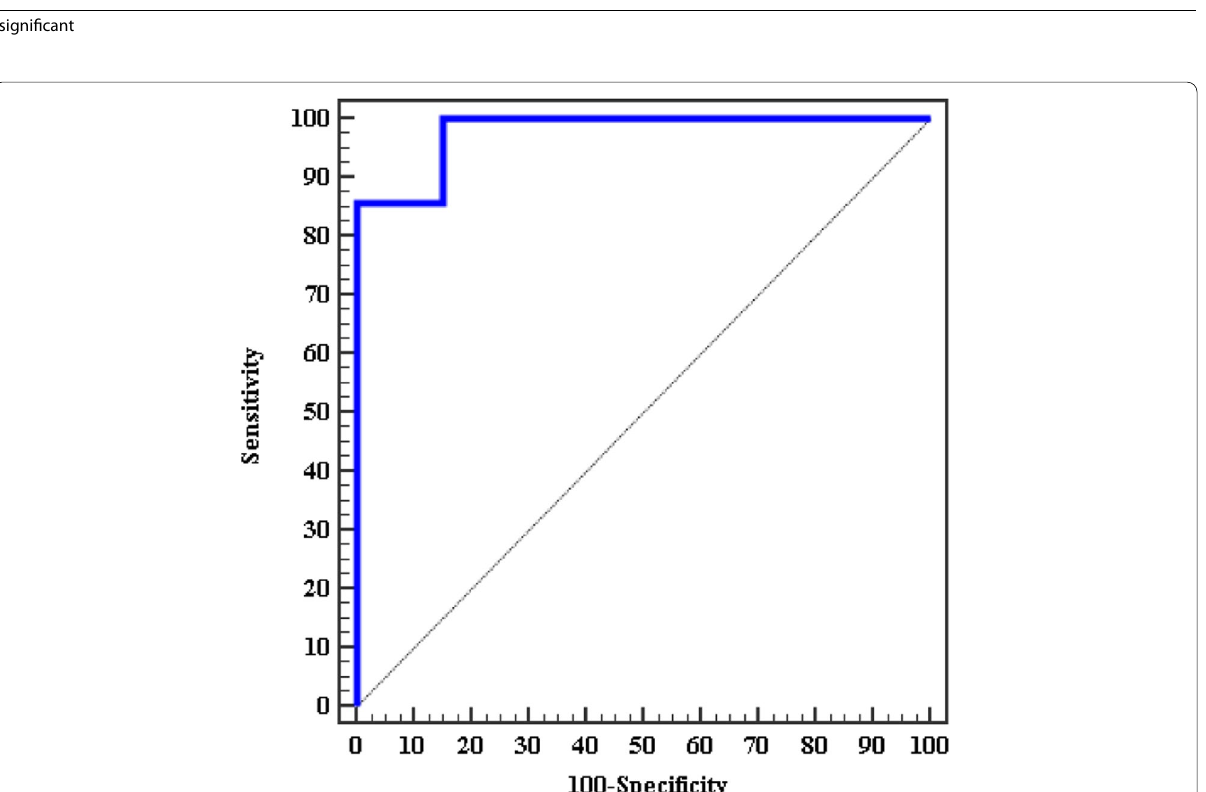
Fig. 1 ROC curve for pretreatment Angiopoietin-2 in discrimination of F4 cirrhosis from